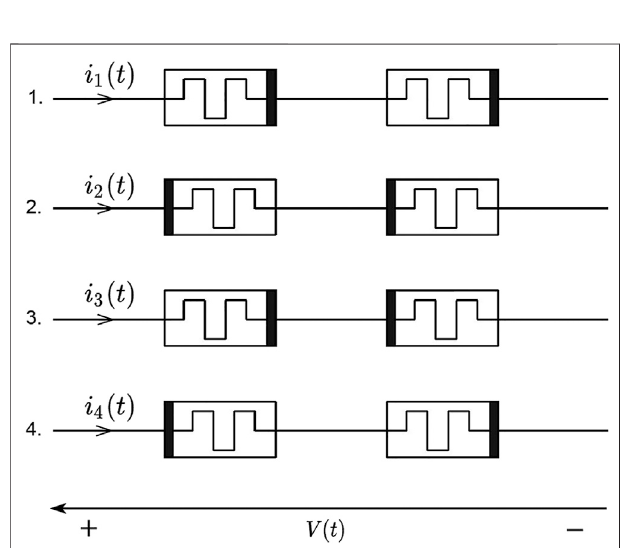
FIGURE 10 | Four possible series connections of two memristors with respecttotheinputsource.Thememristiveeffectisretainedforcases1and 2 whereas it is balanced for cases 3 and 4 (Joglekar and Wolf (2009)). Although cases 3 and 4 are identical and both form a memristor fuse, only case 3 is commonly considered as memristor fuse formation (Gelencser et al. (2012)).